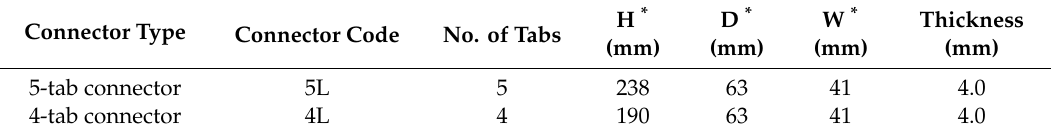
Table 3. Dimensions of the beam end